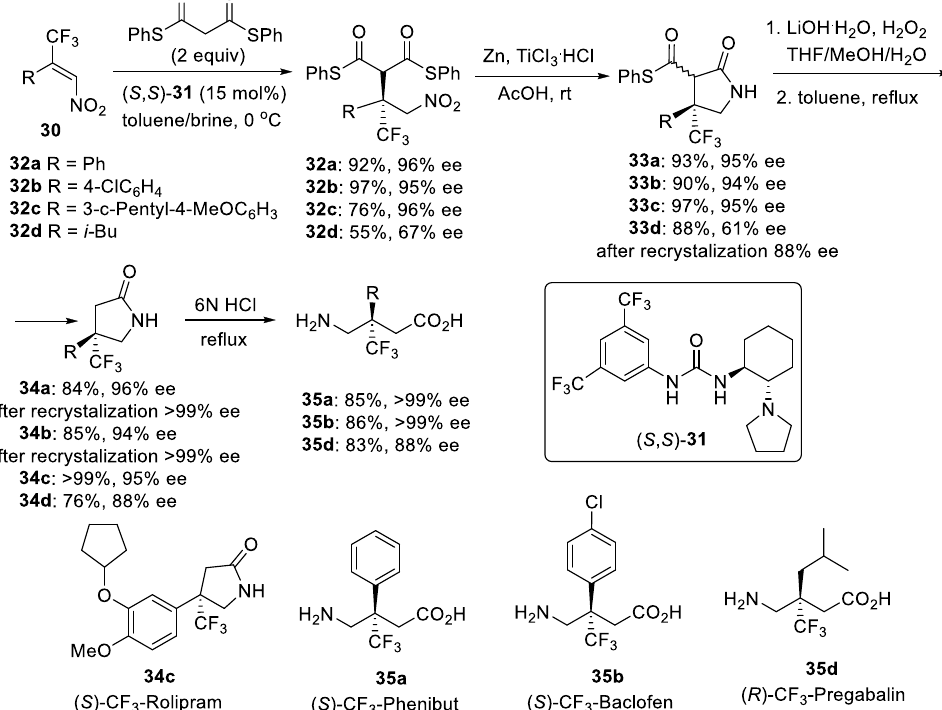
Molecules 2022 , 27 , x FOR PEER